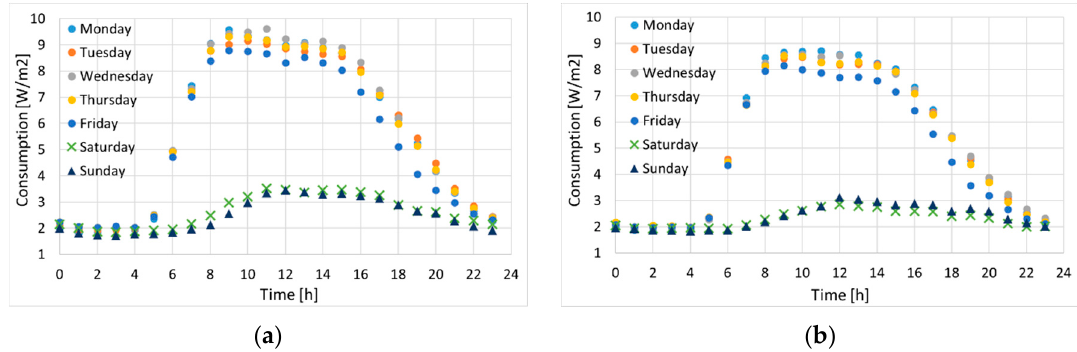
Figure 14. Tenants’ electric consumption for representative weeks: ( a ) January; ( b ) August.